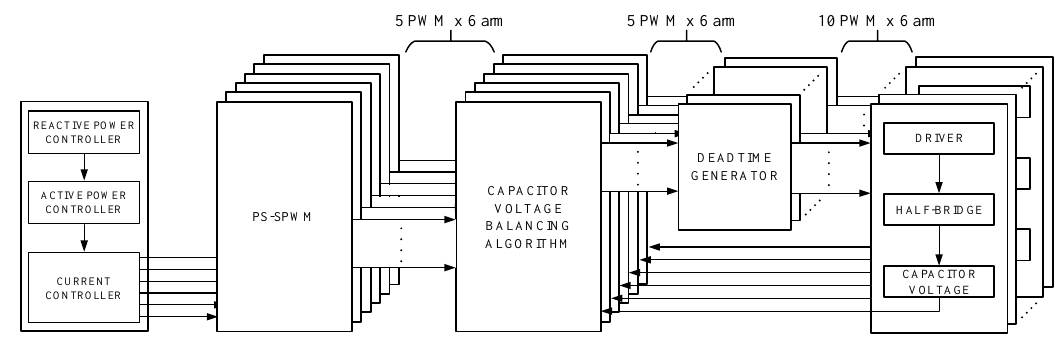
Figure 17. PS-SPWM full control diagram.